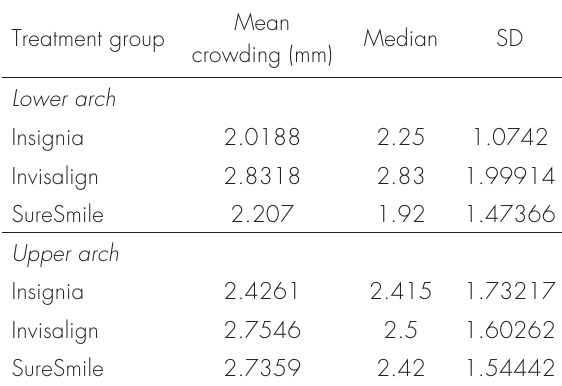
Table IV. Lower and upper arch inital crowding/spacing (positive value indicates crowding in